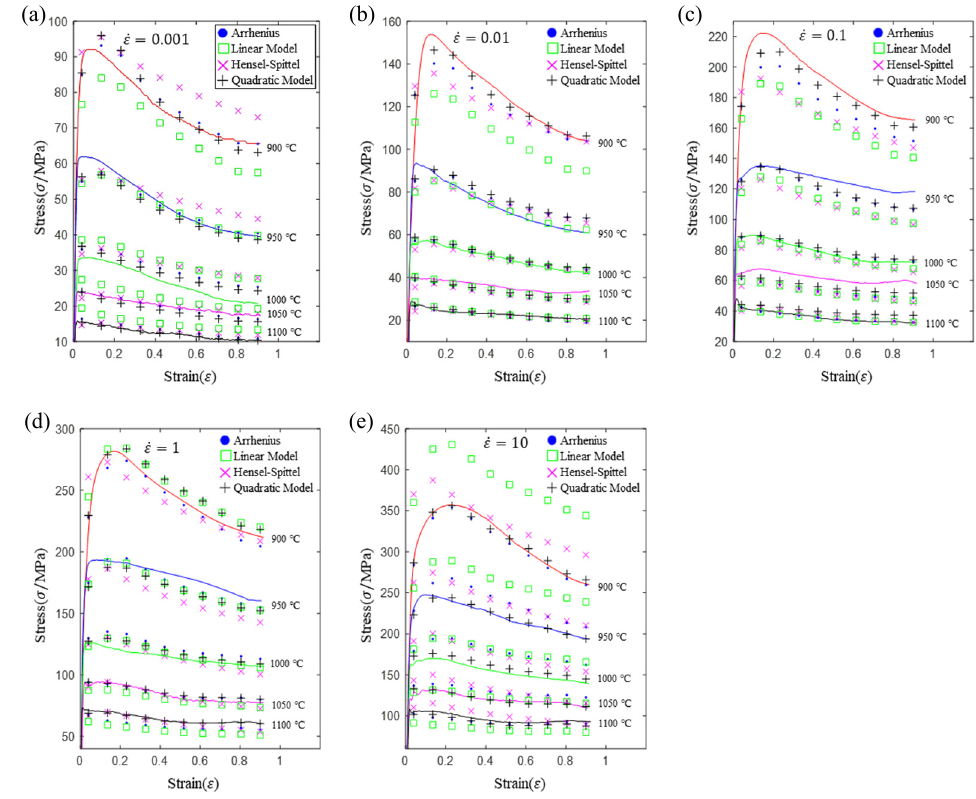
Figure 11. Comparison of prediction flow stress and experimental flow stress for Arrhenius, HS, linear and quadratic models: ( a ) 0.001 s − 1 ; ( b ) 0.01 s − 1 ; ( c ) 0.1 s − 1 ; ( d ) 1 s − 1 ; ( e ) 10 s − 1 .